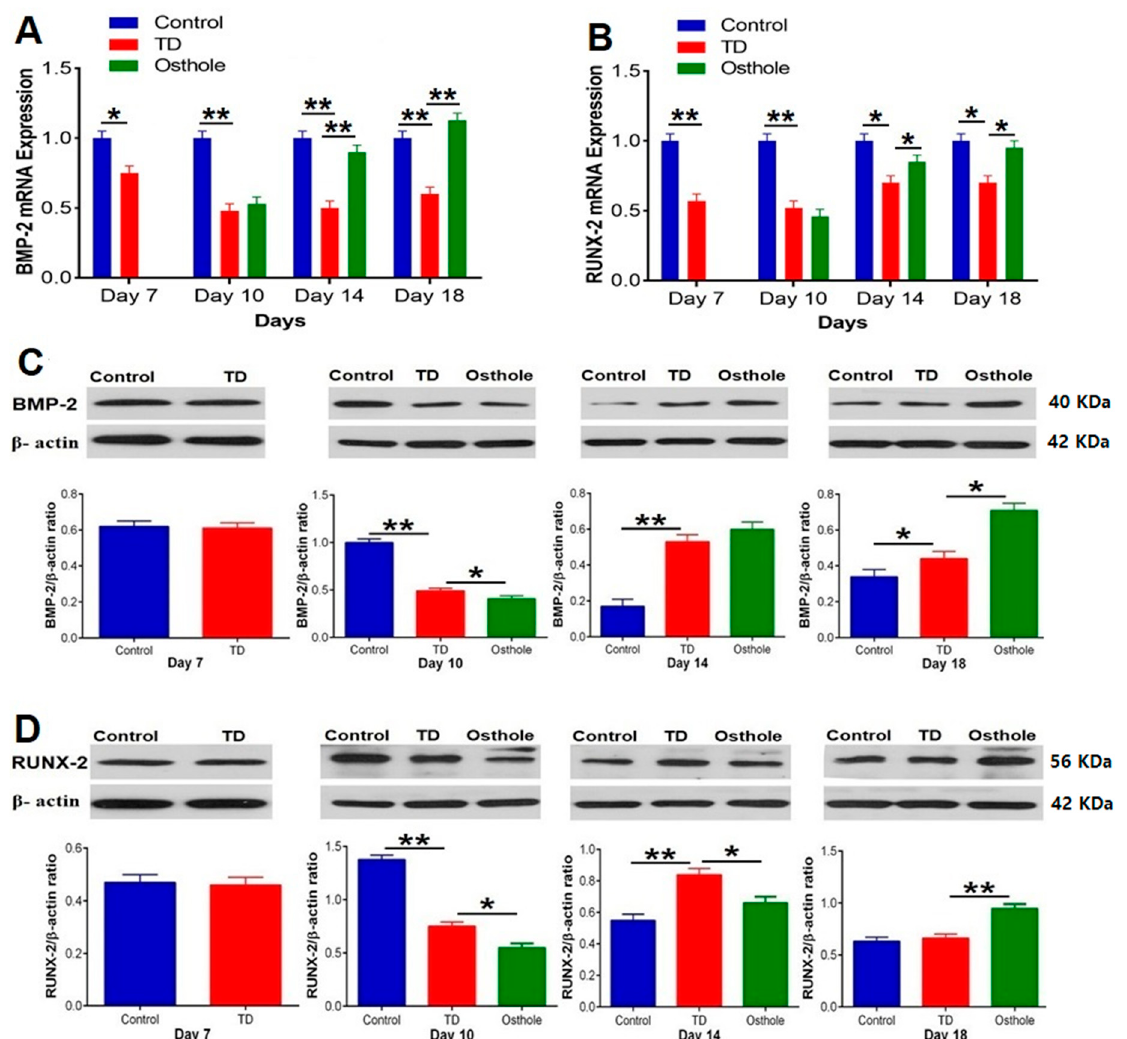
Figure 11. RT-qPCR and western blot analysis of BMP-2 and RUNX-2 in the control, thiram, and osthole groups: ( A ) BMP-2 mRNA expression, ( B ) RUNX-2 mRNA expression, ( C ) BMP-2 protein expression, and ( D ) RUNX-2 protein expression. The bands were quantified using Image Studio Lite 5.2.5 ® (LI-COR Biosciences, Lincoln, NE, USA). The data are expressed as the mean ± SD (* p < 0.05). TD—Tibial dyschondroplasia.